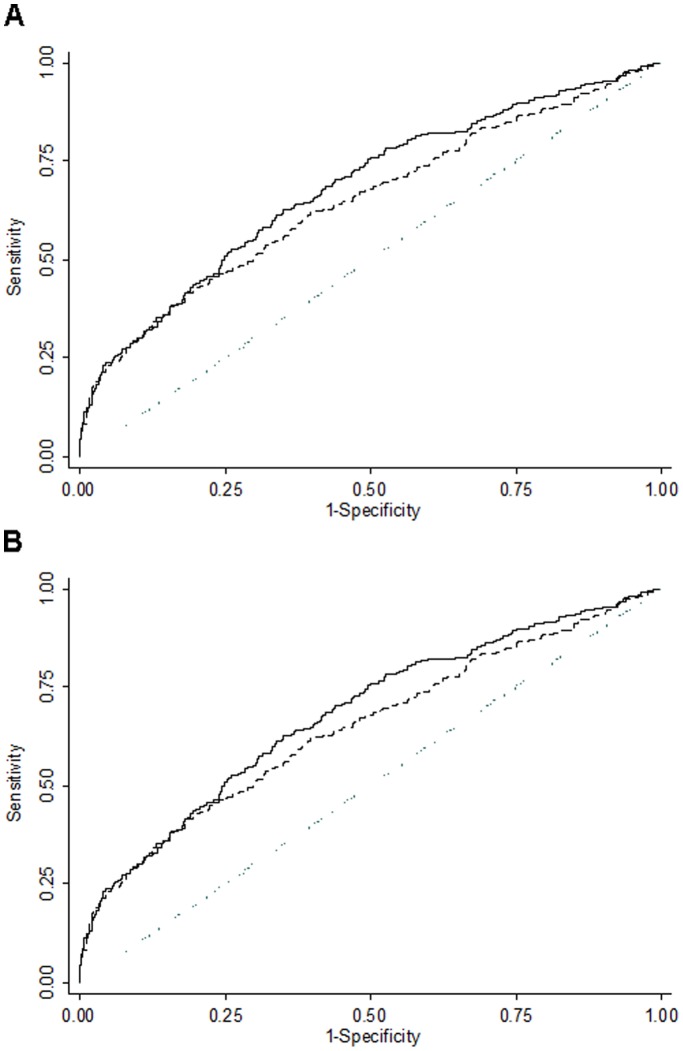
ROC curves and AUC for the inclusive risk score and PSA plus age alone.(A) All prostate cancer and (B) restricted to high-grade prostate cancer. Solid line corresponds to the all inclusive score, whereas dashed line represents the PSA and age risk score. The dotted line indicates the behavior of a hypothetical random score. The Likelihood ratio test was used to estimate the superiority of the inclusive risk score relative to that of the age+PSA score for all prostate cancer (inclusive: AUC = 0.6806, PSA and age: AUC = 0.6476, P = 0.0002) and high-grade prostate cancer (inclusive: AUC = 0.7119, PSA and age: AUC = 0.6808, P = 0.0001). PSA, prostate specific antigen.